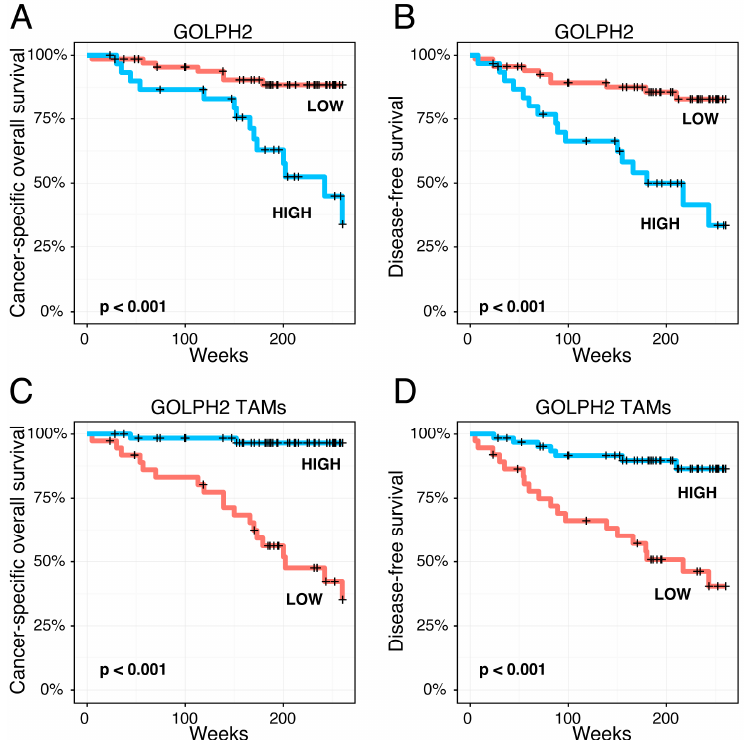
Figure 4. Kaplan-Meier analysis of the prognostic impact of GOLPH2 expression in cutaneous melanoma patients. Enhanced GOLPH2 immunoreactivity in melanoma cells was significantly associated with shorter cancer-specific overall survival (CSOS) and disease-free survival (DFS) ( A and B , respectively); Upregulation of GOLPH2 in tumor-associated macrophages demonstrated contrary prognostic significance and was strongly correlated with longer CSOS and DFS ( C and D ,